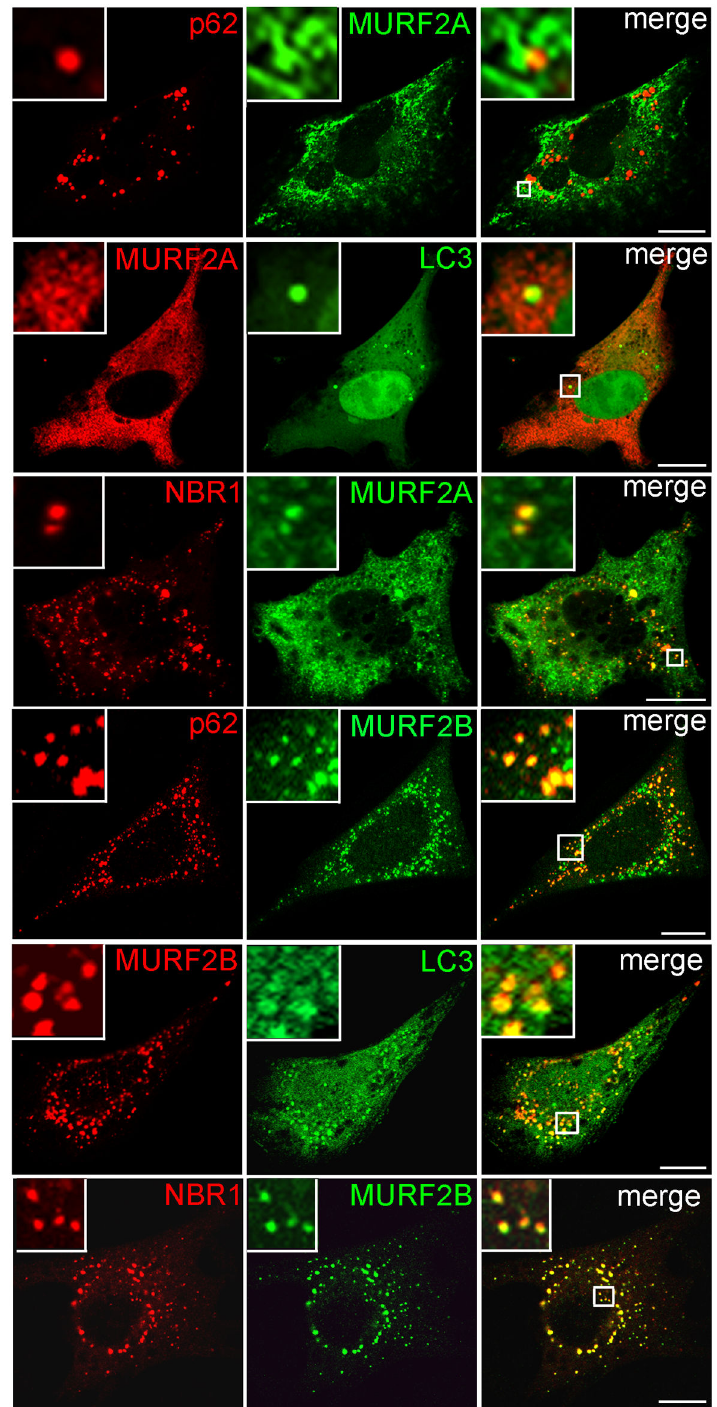
Figure 2. Parallel localization of MURF2 isoforms with LC3, p62 and NBR1. Plasmids expressing the indicated fluorescent proteins were used for double transfection experiments in C2C12 myoblasts. The mCherry (red) and the GFP (green) fluorescence were directly observed by confocal microscopy. Scale Bar: 10 µm.